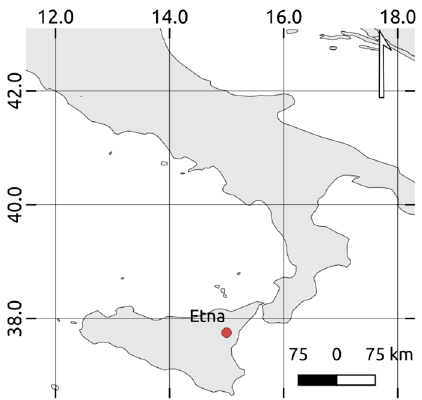
Figure 1. Geographic location of Mt. Etna (Sicily, Italy).